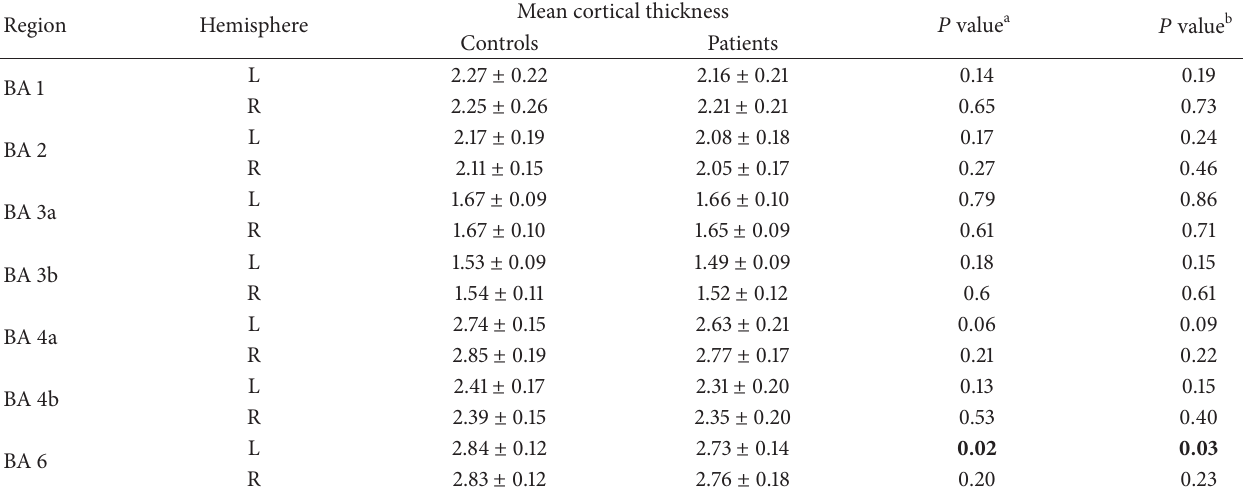
Table 5: The differences of mean cortical thickness in the sensorimotor cortices between the amputees and normal controls. Region